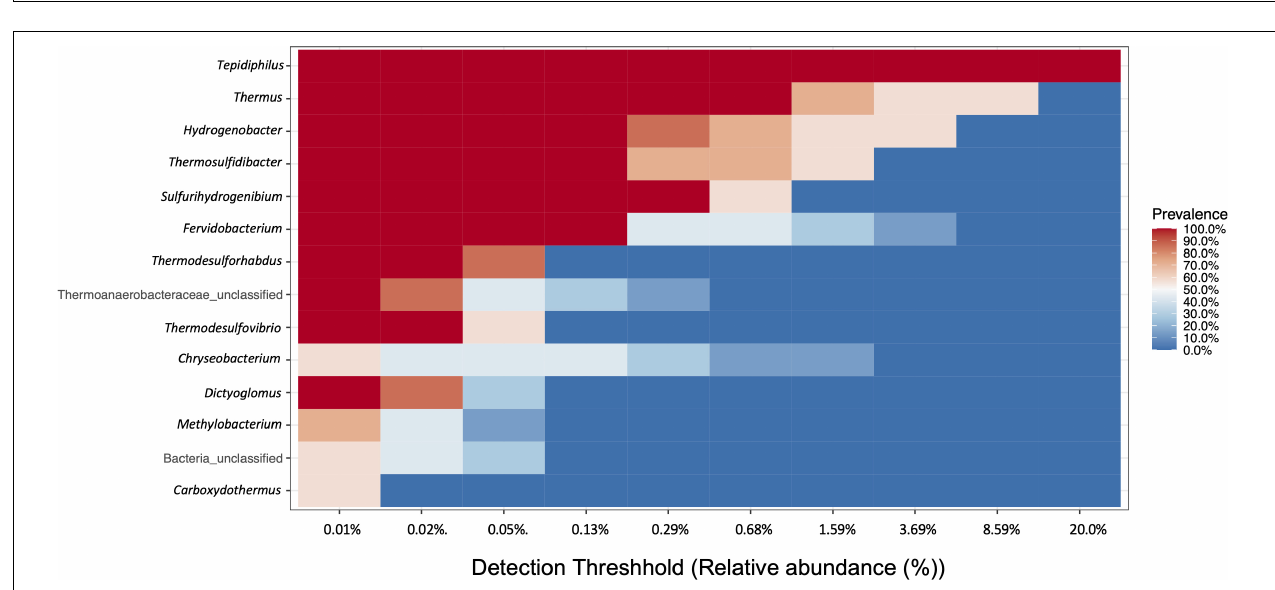
FIGURE 2 | (A) Beta diversity analysis. NMDS ordination analysis comparing the structure of the microbial communities of the injection (IW) and produced waters (Adonis test p < 0.05). (B) Bacterial genus frequencies. Stacked histogram depicting the normalized relative abundance of the top 10 most frequent bacterial genera detected in the metataxonomic analysis of the injection (IW) and produced waters (PW).